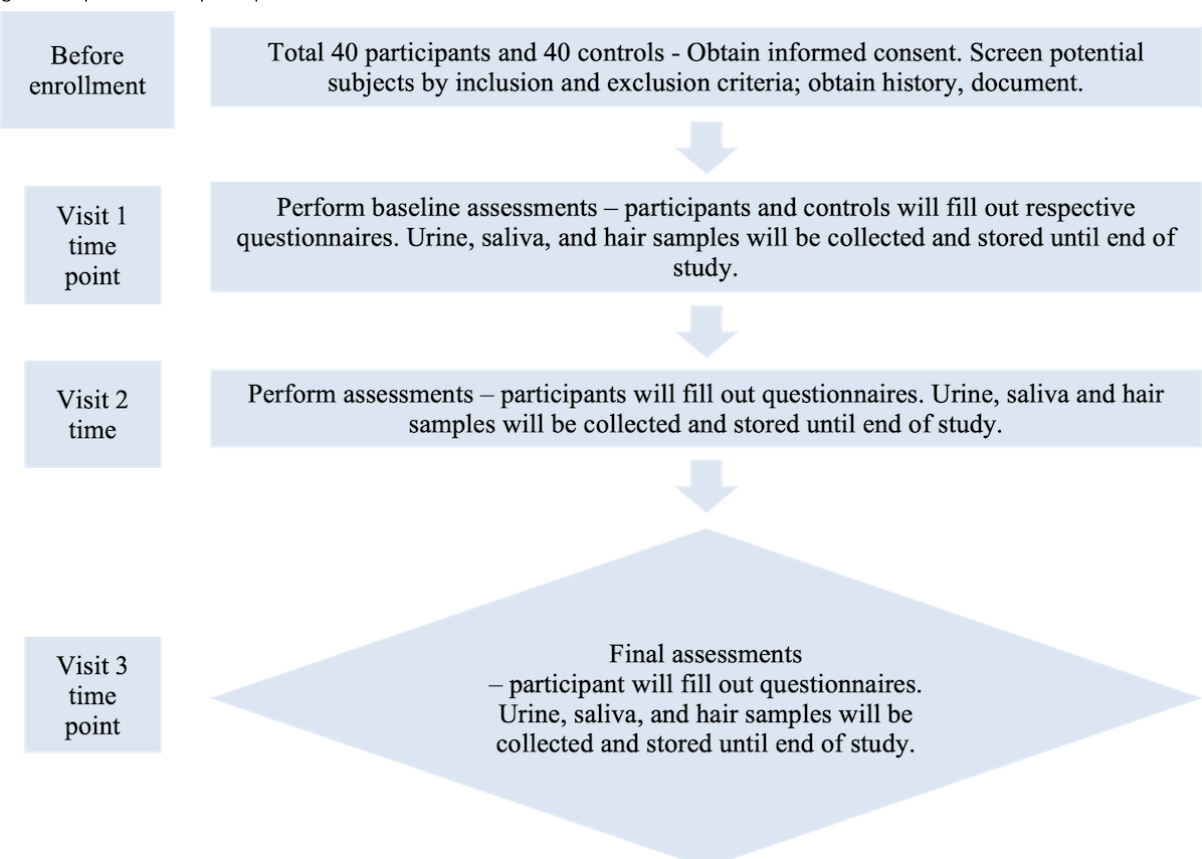
Figure 1. Schematic of the study design. This schematic demonstrates the tasks completed at enrollment and at each subsequent visit for transgender and gender expansive TGE